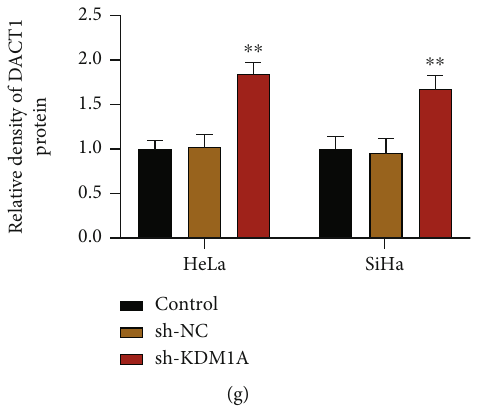
Figure 4: KDM1A negatively regulates DACT1 in cervical cancer cells. (a) STING predicted the interaction between KDM1A and HDAC1; (b) UCSC analysis showed the elevated signals in the prompter of HDAC1 after histone 3 deacetylation; (c) CoIP identi fi ed the interaction between KDM1A and DACT1; (d) the deacetylation of histone 3 was measured by western blot; (e) in HeLa and SiHa cells, KDM1A knockdown on mRNA expression level of DACT1; (f, g) in HeLa and SiHa cells, KDM1A knockdown on protein expression level of DACT1. ∗ p < 0 : 05 and ∗∗ p < 0 : 01 , compared with the control